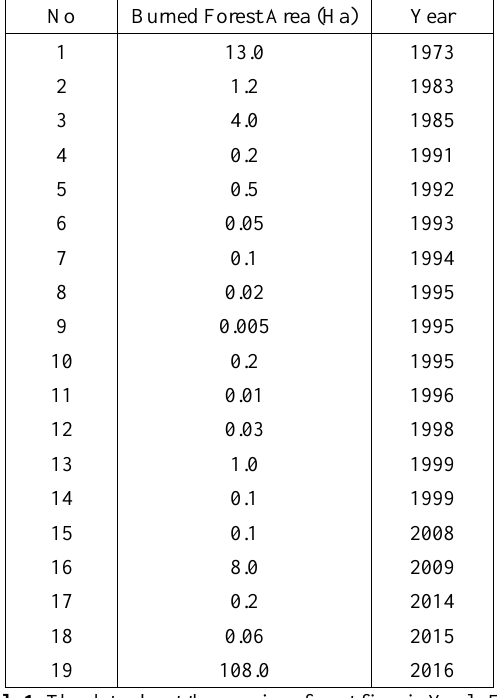
Table 1 . The data about the previous forest fires in Yayla FEC.